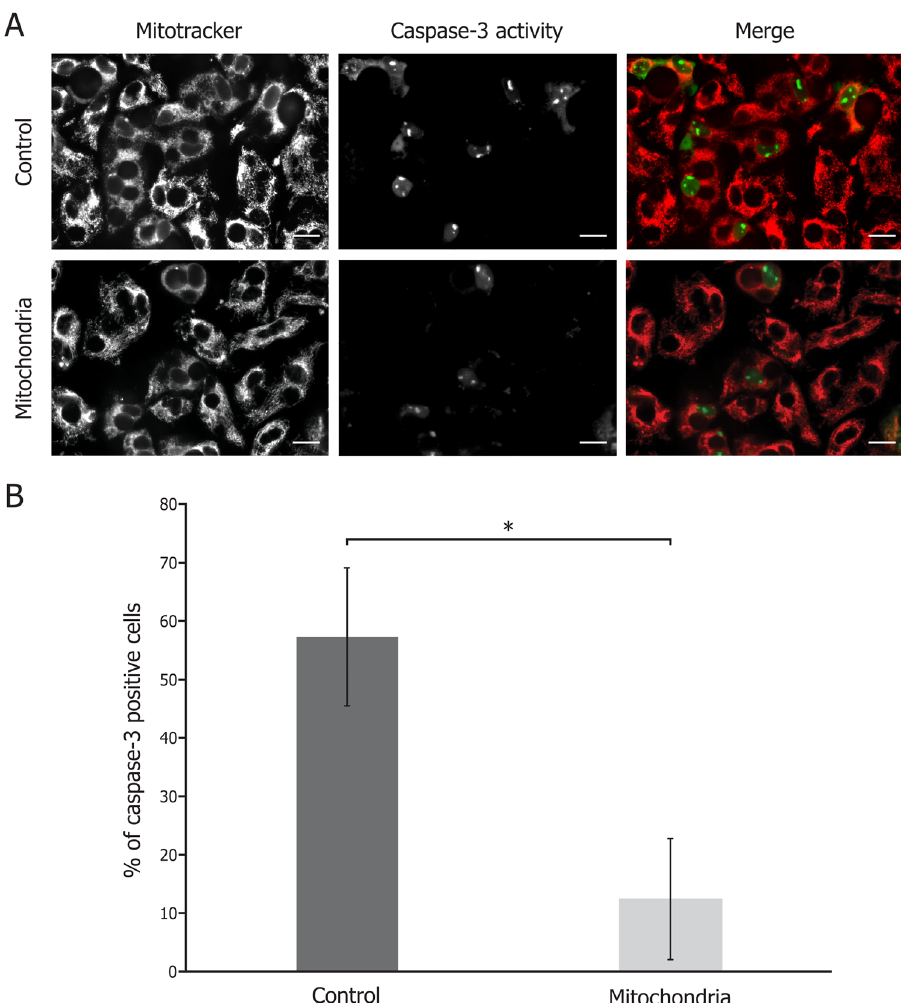
Figure 5. Apoptosis is reversed by exogenous mitochondria internalization by co-incubation with FECD cells. ( A ) A marker of apoptosis (caspase 3/7 activity; green) in conjunction with a mitochondrial mass marker (mitotracker; red) in FECD explants that received exogenous mitochondria or not (control). ( B ) The number of apoptotic cells is lower in mitochondrial treated FECD explants, when compared to control. Scale bar = 40 µm. Experiments were performed with 4 explants from 4 FECD patients (38 microscope fields analyzed). Other representative images of the 4 explants have been added to the Supplementary Materials (Fig. S3). *p <